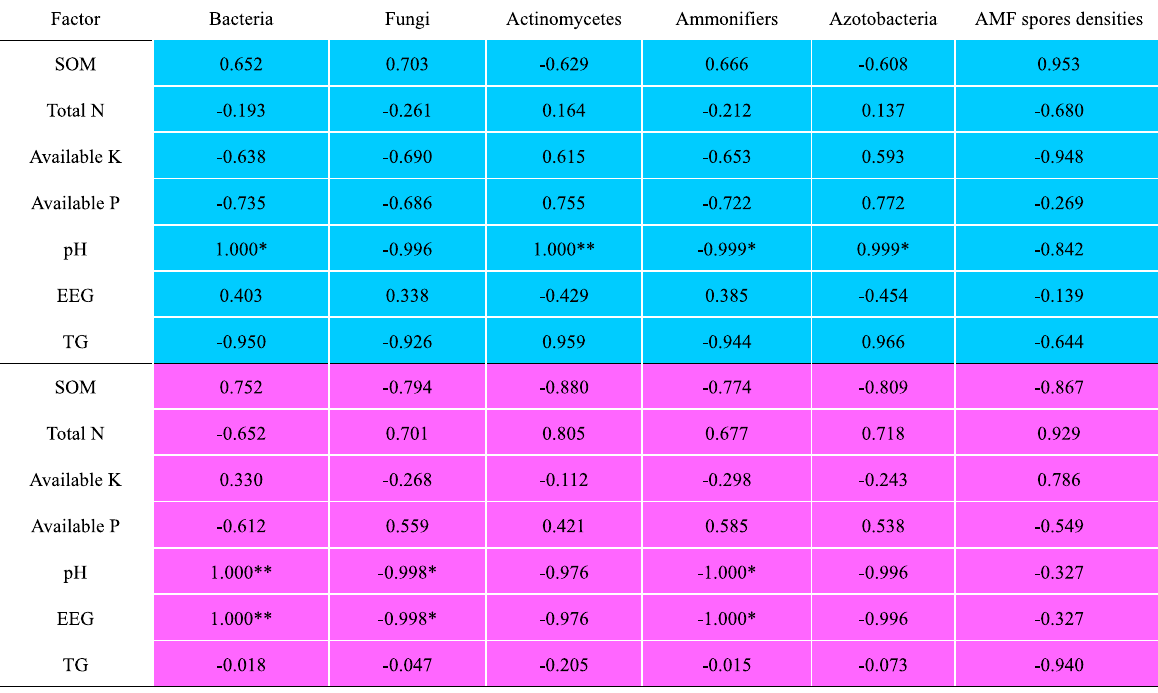
Values were presented in table as the Pearson’s correlation coefficient, n SOM soil organic matter, total N total nitrogen, available P available phosphorus, available K available potassium, EEG easily extractable glomalin, TG total extractable glomalin * and ** indicate significance at the 0.05 and 0.01 level of probabilities in correlations between rhizosphere soil microbial populations and physicochemical parameters of RW and